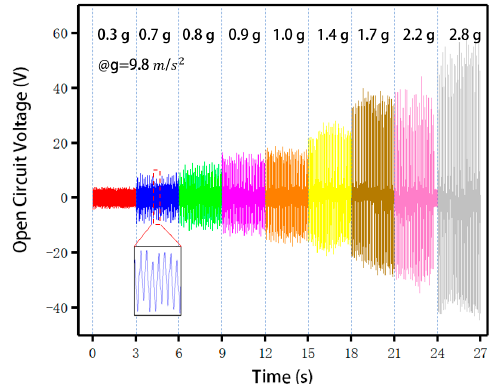
Figure 9. The open-circuit voltage of the flexible and stretchable energy harvester under different press accelerations.